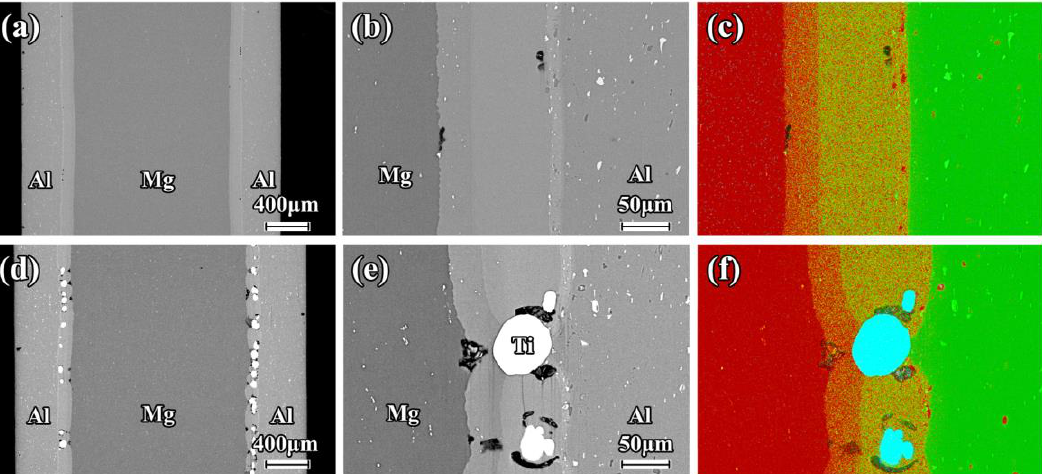
Figure 4. Low magnification and high magnification cross-sectional SEM micrographs of composite sheet after annealing at 400 ◦ C for 10 h: ( a – c ) Mg/Al, and ( d – f ) Mg/Al-Ti. EDS mapping showing the element distribution of Al (green points), Mg (red points), and Ti (blue points).